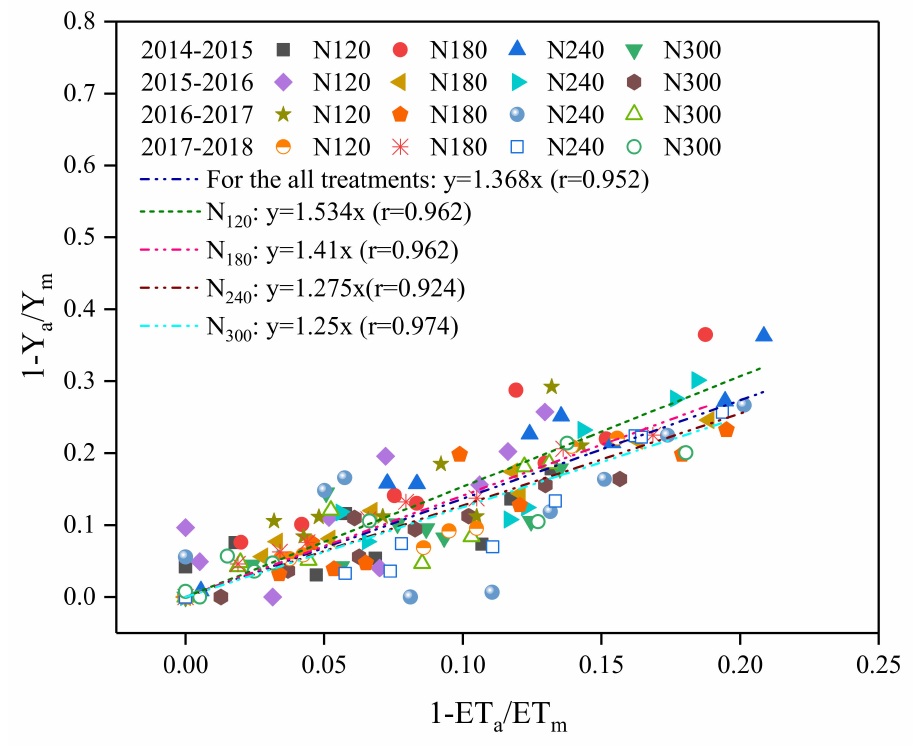
Figure 5. Yield response factors ( K y ) in the di ff erent treatments over the four consecutive wheat seasons from 2014 to